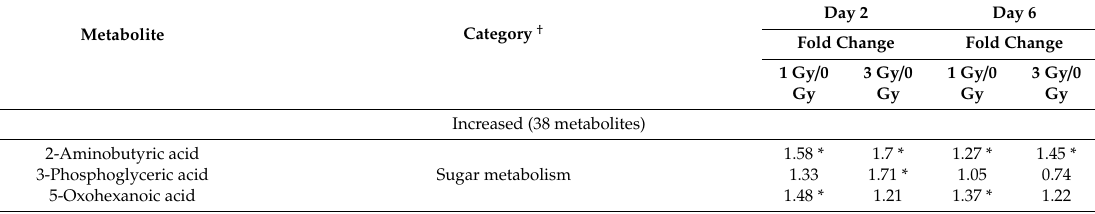
Table 1. Changes in the levels of blood cell metabolites following exposure to ionizing